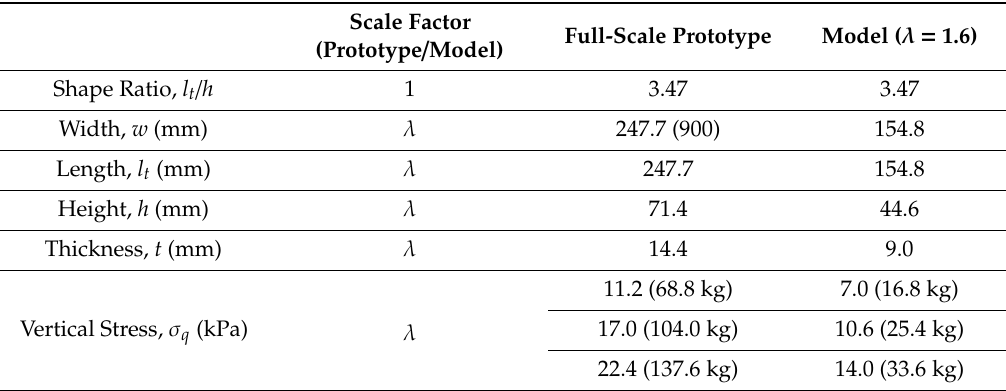
Figure 4. Schematic diagram of the model track system used for the model track experiments in this study ( w and t represent the width and thickness of the track system, respectively, l t represents soil–track contact length of the single-track system, and h represent the grouser height). Table 1. Material properties of the full-scale prototype and model track system.